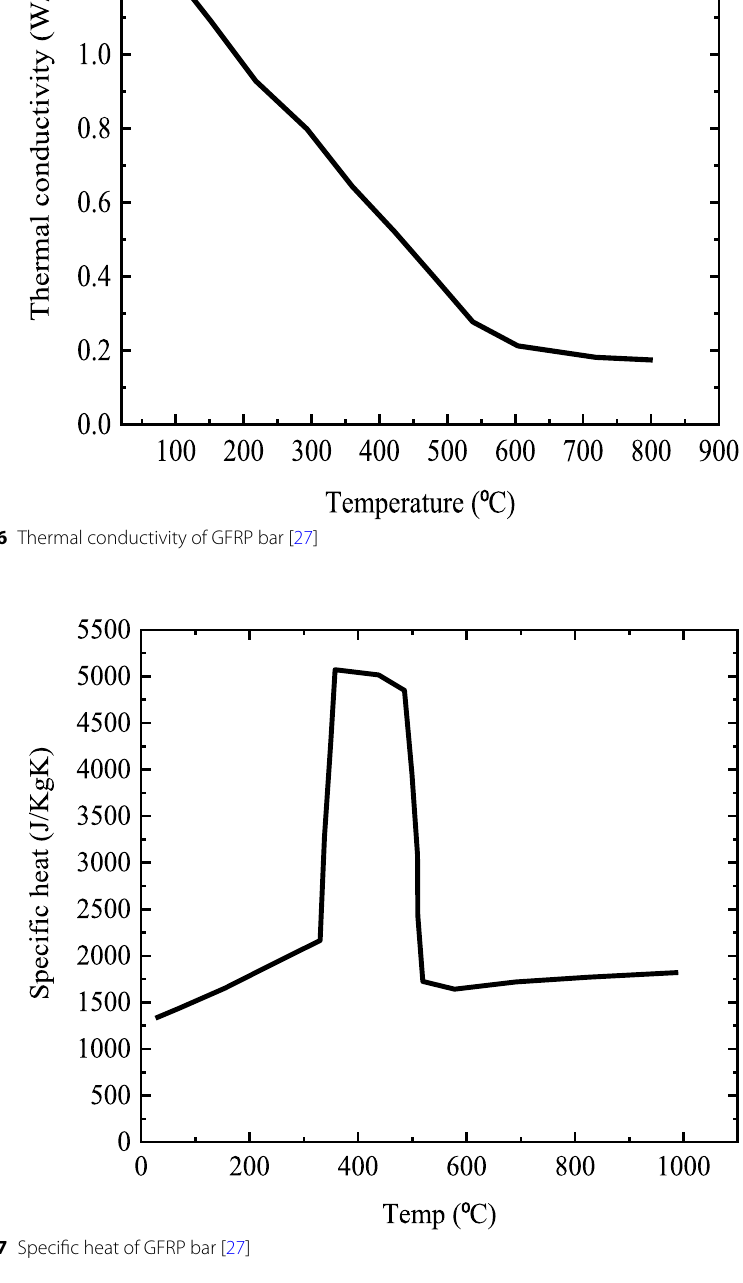
Parameters of the study